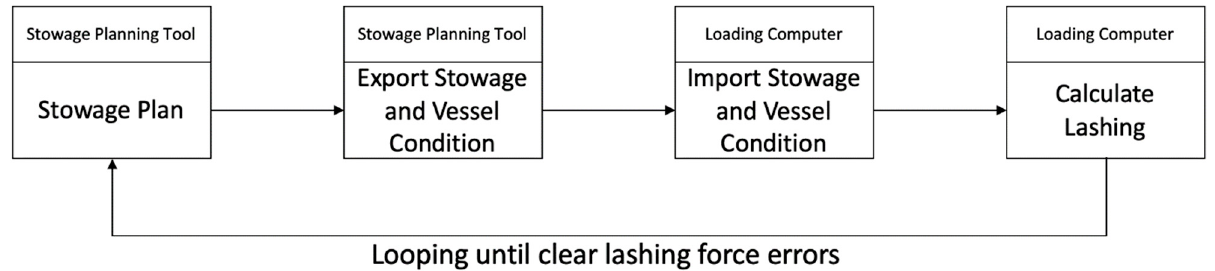
Figure 2. Typical process of lashing verification during the stowage planning.